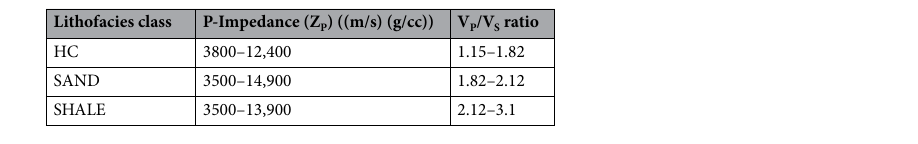
Table 1. Interpreted ranges of conventional attributes for lithofacies